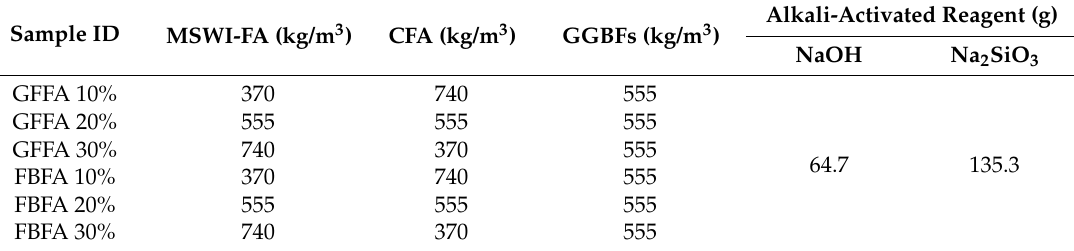
Table 3. The mix proportion design of municipal solid waste incineration fly ash (MSWI-FA) containing alkali-activated